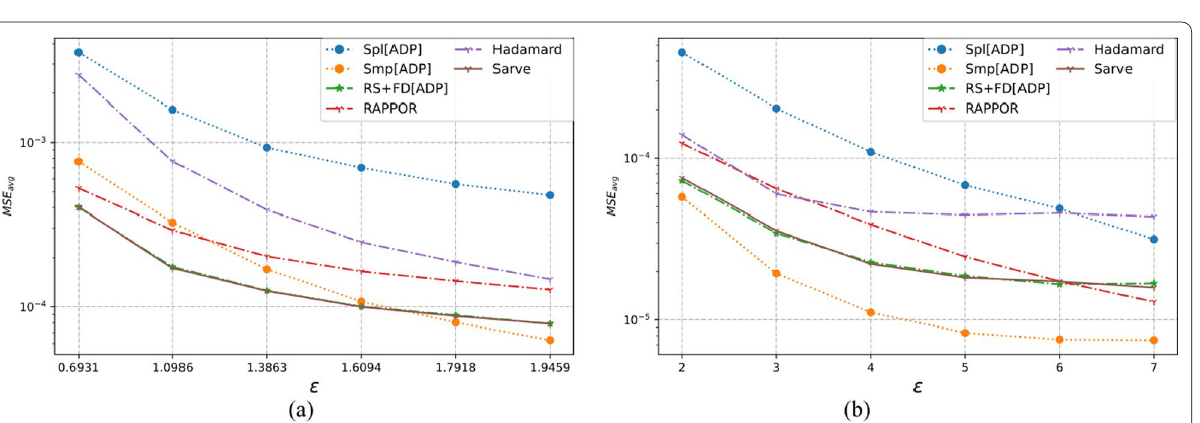
Fig. 8 The MSE averaged over 100 runs for synthetic data with N under a high privacy regime, experimental setup labeled ES_Syn_1 in Table 2; b general privacy regime, experimental setup labeled ES_Syn_7